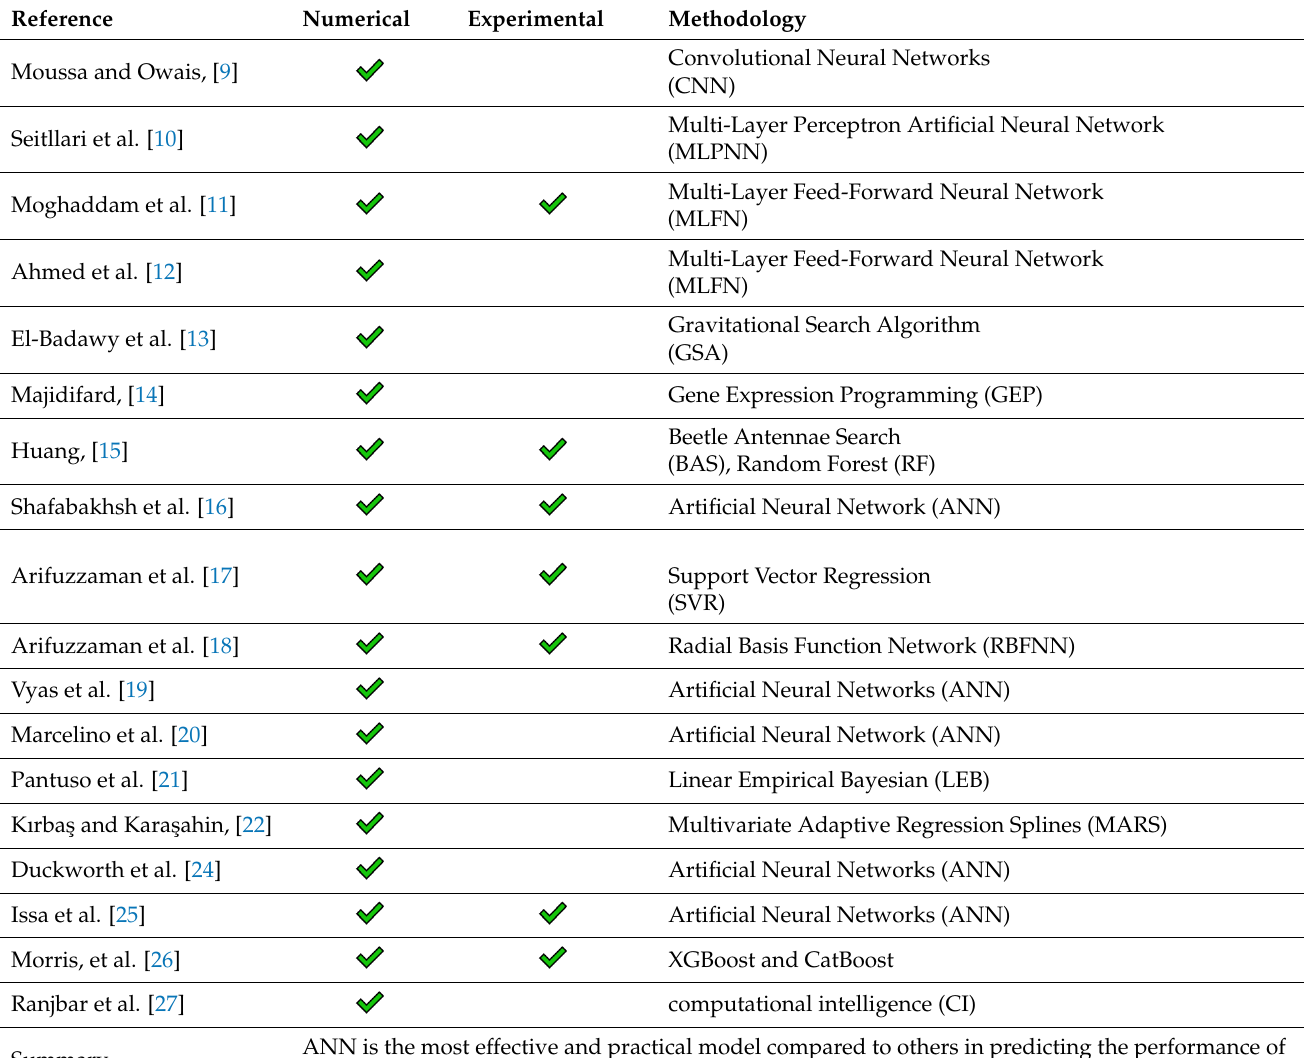
Table 2. Comparison of methods used in prediction of flexible pavement performance.